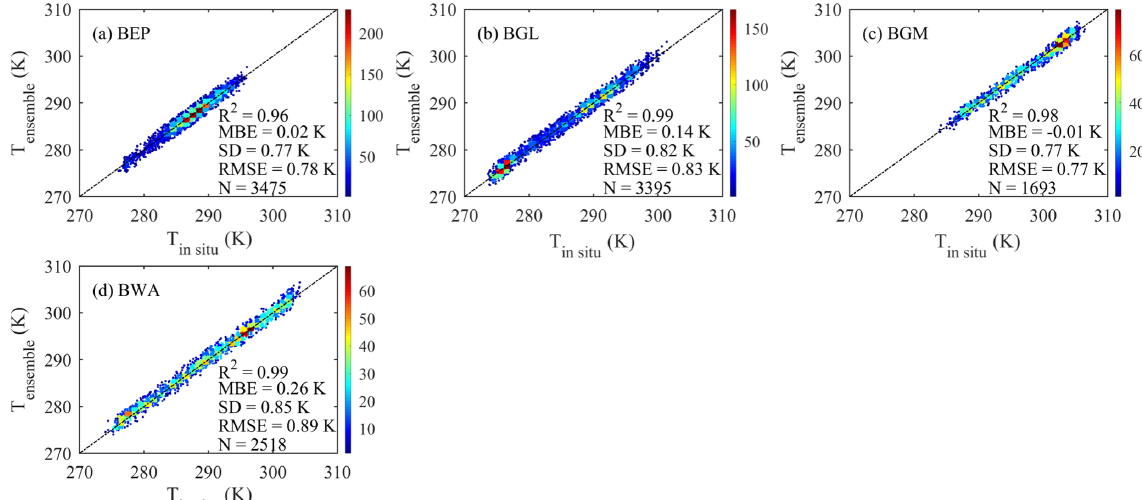
Figure 9. RF-SWA LST against in situ LSWT from four NDBC sites (buoy data) and corresponding statistics.